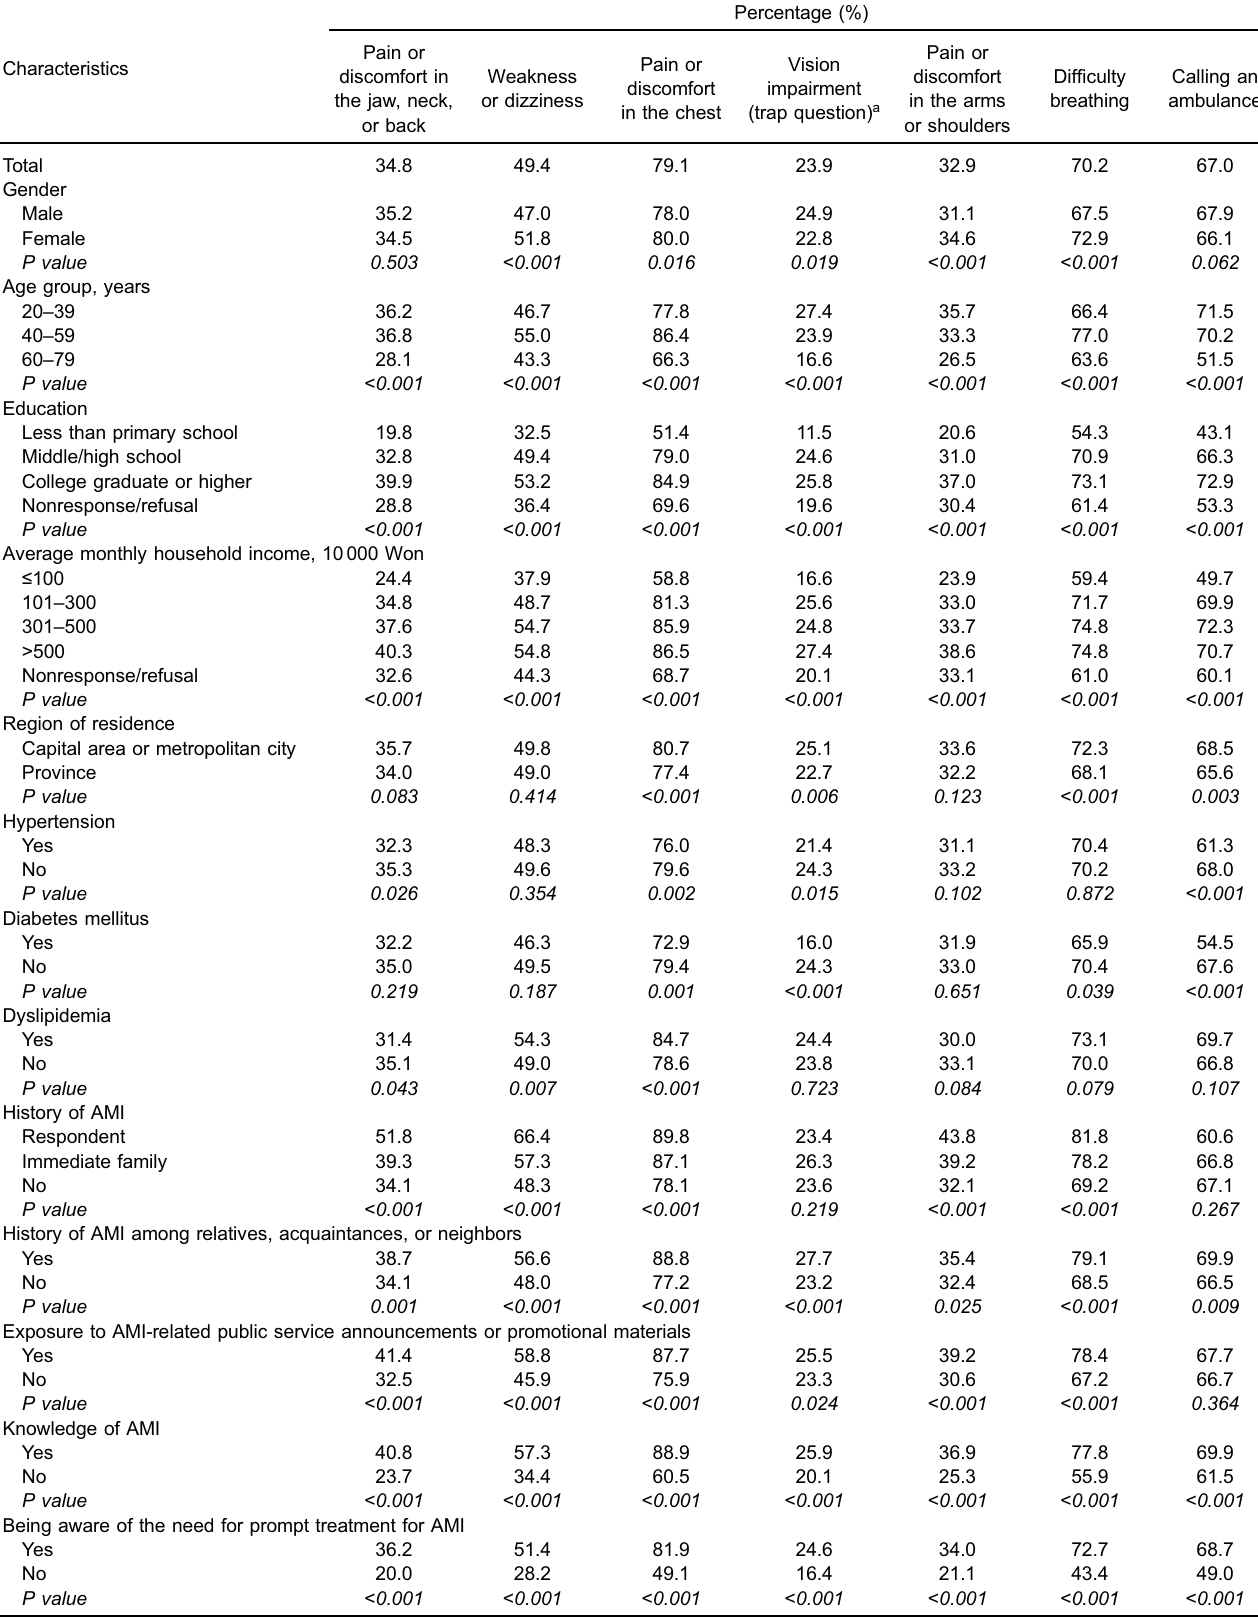
Table 2. Awareness of each symptom of acute myocardial infarction and calling an ambulance